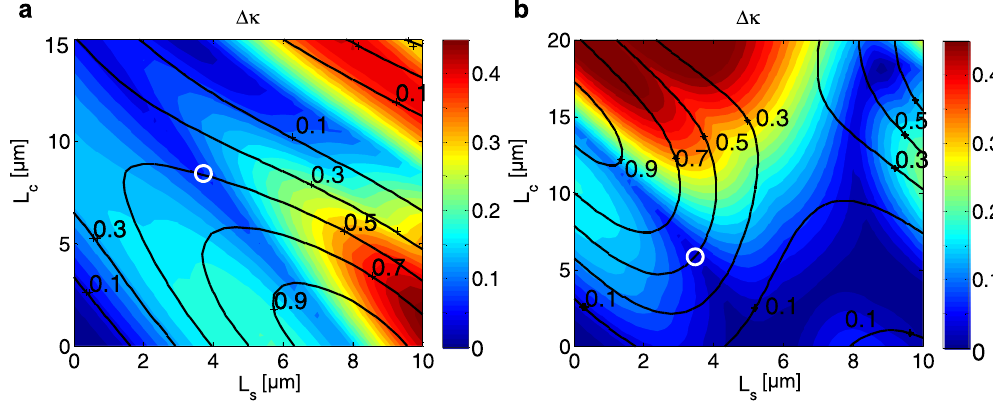
Figure 2. Maximum cross coupled power deviation Δ κ versus straight ( L s ) and curved ( L c ) lengths of curved directional coupler for ( a ) R c = 26 μ m, g = 200 nm, w 1 = w 2 = 400 nm, ( b ) R c = 13 μ m, g = 200 nm, w 1 = 380 nm, w 2 = 420 nm. The black contour overlay indicates the cross port power κ at 1570 nm. The white circles indicate chosen dimensions for a wavelength insensitive 50/50 coupler.